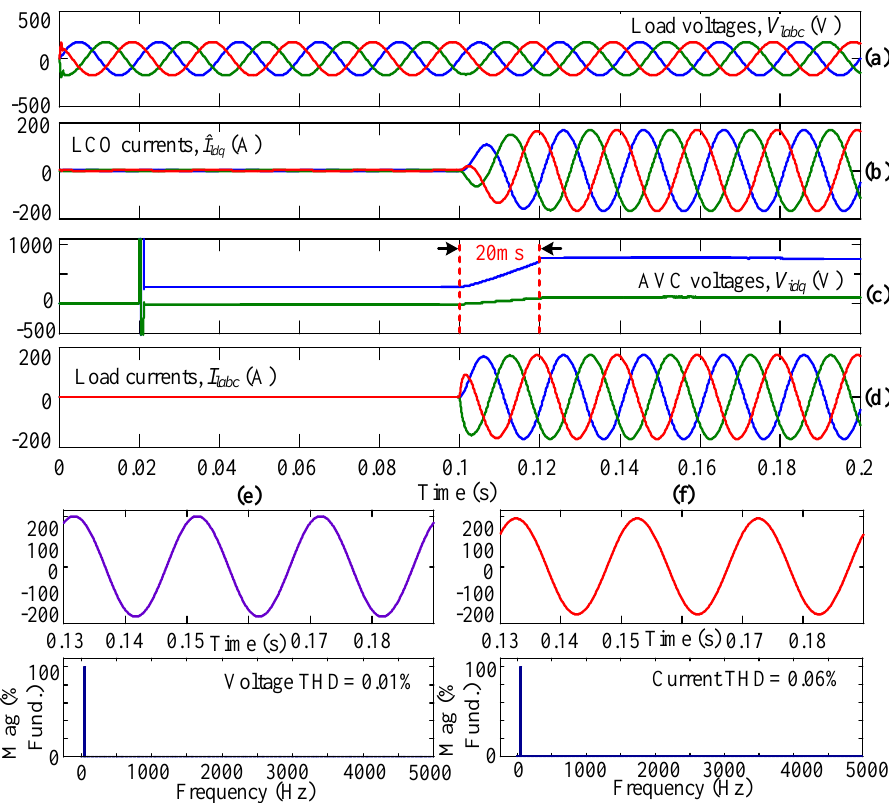
Figure 11. Simulation results for case-IV with balanced load condition.